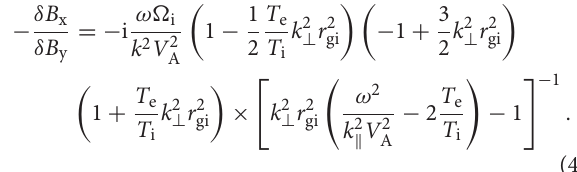
Like the magnetic